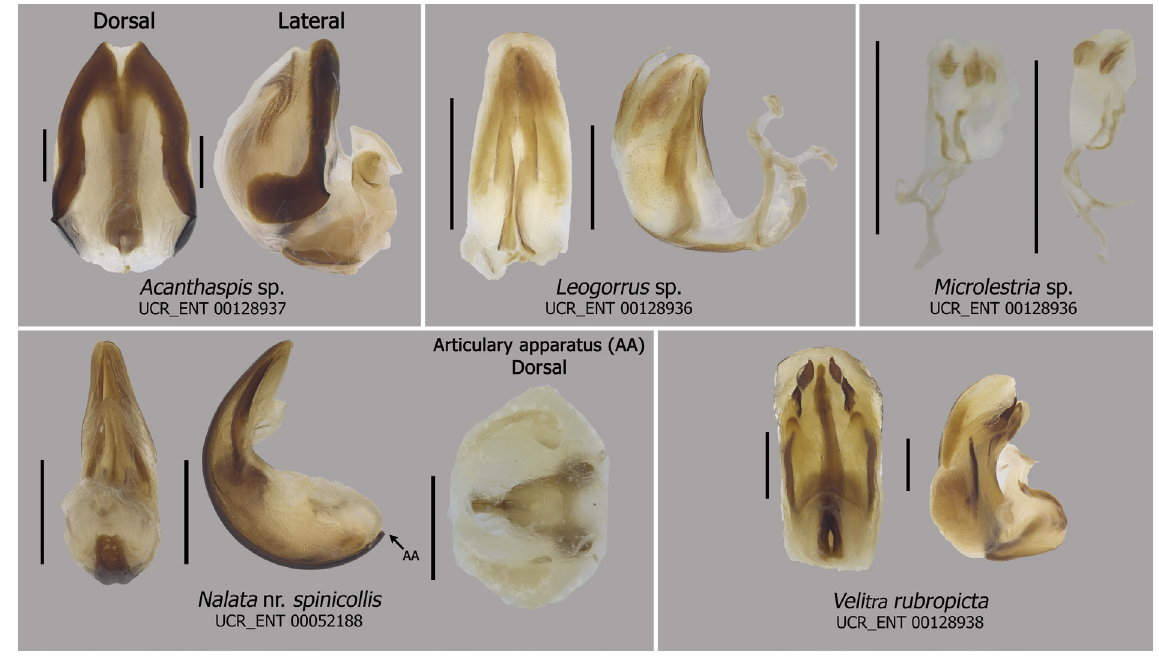
Fig. 16. Aedeagus of outgroup species. Scale bars = 0.5